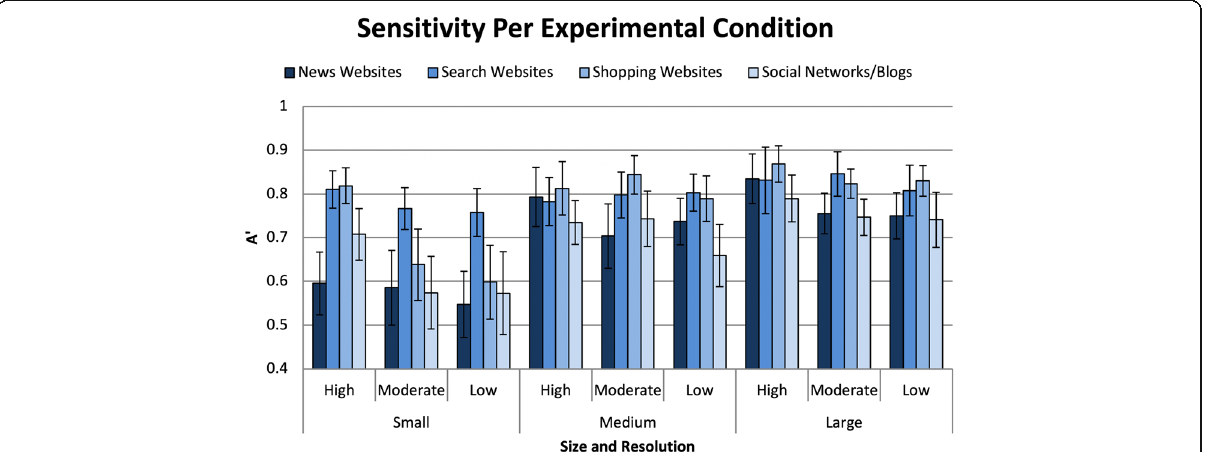
Fig. 13 Sensitivity for detecting websites in each of the size and resolution conditions. Error bars are within-subjects 95% confidence intervals (Cousineau, 2005; Morey,